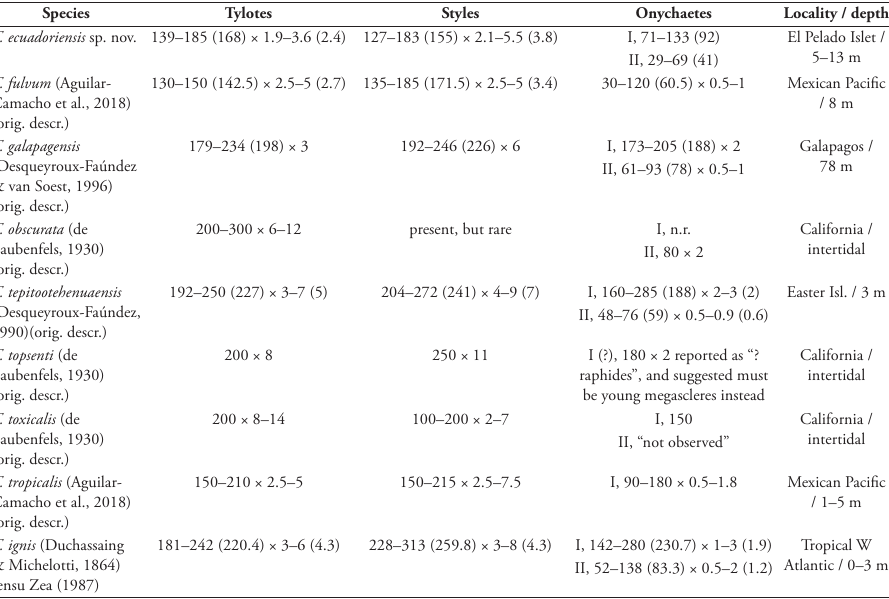
table 1. Morphology of spicules, locality and depth, for East Pacific Tedania spp. seemingly closer to T. ( T. ) ecuadoriensis sp. nov., and T. ignis . Spicule morphometrics are in micrometres as range with the mean in parentheses, n.r. is not